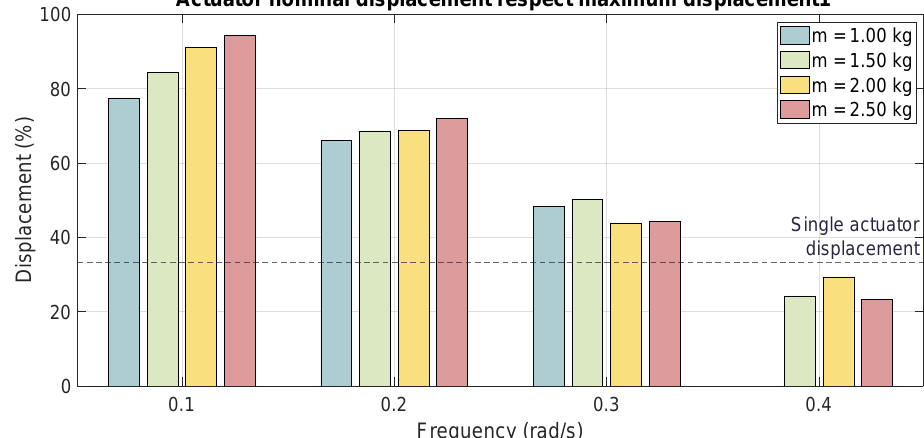
Figure 13. The actuator’s nominal displacement in comparison with a single actuator’s maximum dis-